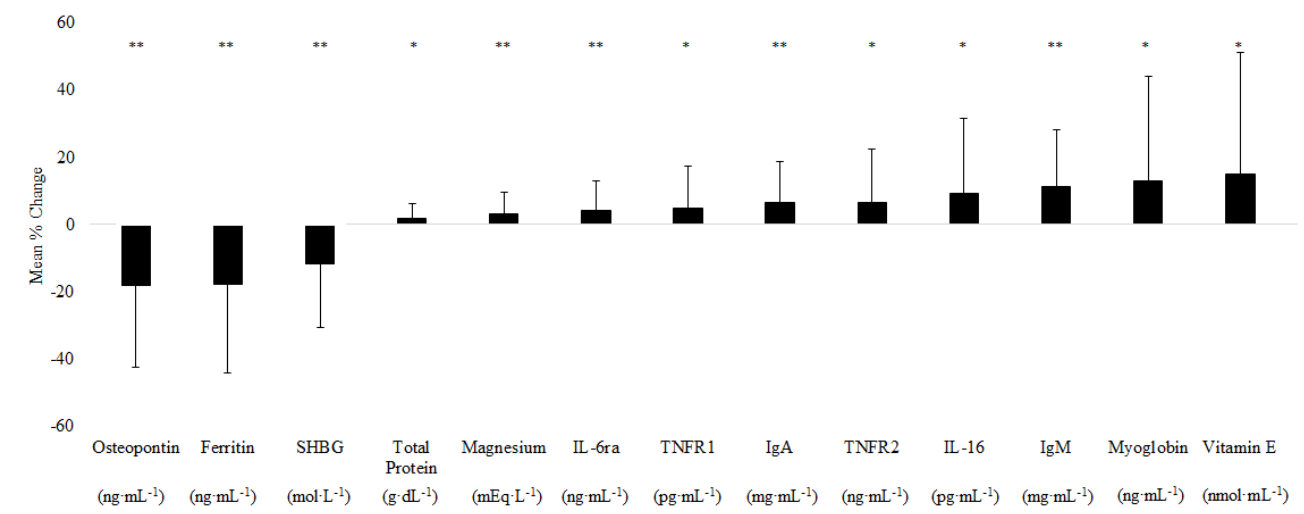
Figure 1. Biomarker changes specific to experimental ONS (E ONS ) following 12-week supplementation. Values are the means ± SD, compared by univariable dependent t -test with Sidak-adjusted p -value < 0.05. Interleukin-6 receptor- α (IL-6ra), tumor necrosis factor receptor-1 (TNFR1), tumor necrosis factor receptor-2 (TNFR2), immunoglobulin A (IgA), immunoglobulin M (IgM), and sex hormone-binding globulin (SHBG). * indicates p < 0.05; ** indicates p < 0.01.